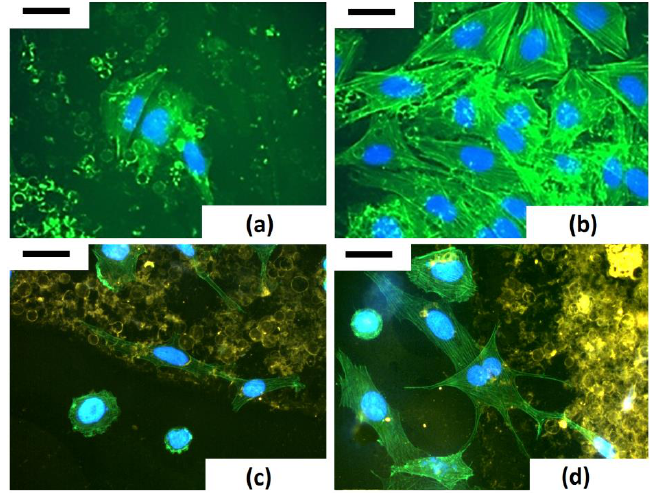
Figure 14. Saos-2 morphological investigations via fluorescence microscopy after double (DAPI + atto-falloidin 488, F 24 ( a ) and F 96 h ( b )) and triple staining with T-BTZ-T (T-BTZ-T + DAPI + atto-falloidin 488, F-T-BTZ-T 24 ( c ) and 96 h ( d )). Marker: 50